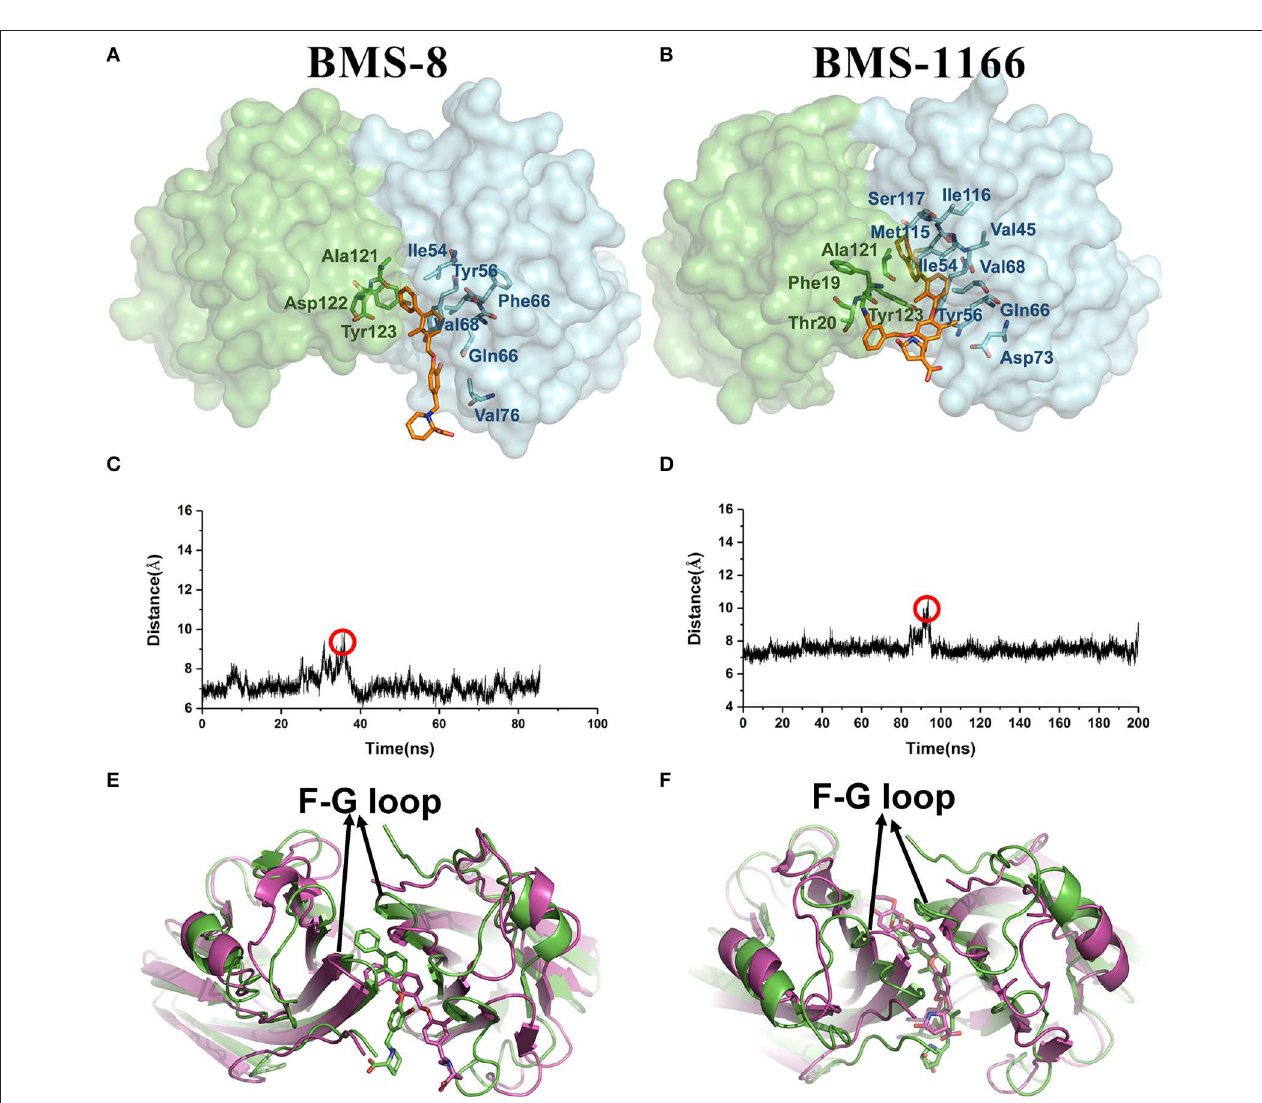
FIGURE 7 | The conformational change during the unbinding process. (A,B) The key transition conformational states of BMS-8 and BMS-1166 during the unbinding process with CV1 value of 12.54 Å and 10.95 Å, respectively. The chain A and chain B of PD-L1 dimers are shown in green and cyan surface, respectively. The key residues (green or cyan) and ligands (orange) are shown in sticks. (C,D) The distance between Ile54, Tyr56, Met115, Ala121, and Tyr123 on conformation A and conformation B of PD-L1 during the unbinding process of BMS-8 and BMS-1166. (E,F) The extracted conformational state (green cartoon) of each complex with the largest distance between two PD-L1 monomers was overlapped with the original crystal structures (magenta cartoon).